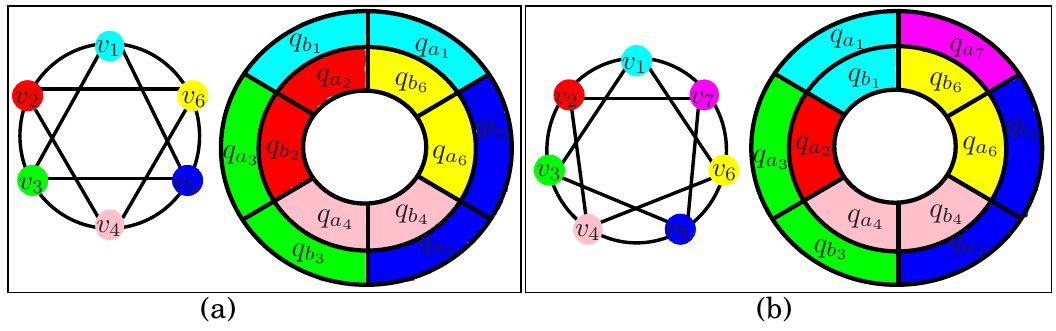
Fig. 4: (a) 2 × n circular grid for even n ; (b) 2 × n circular grid for odd n